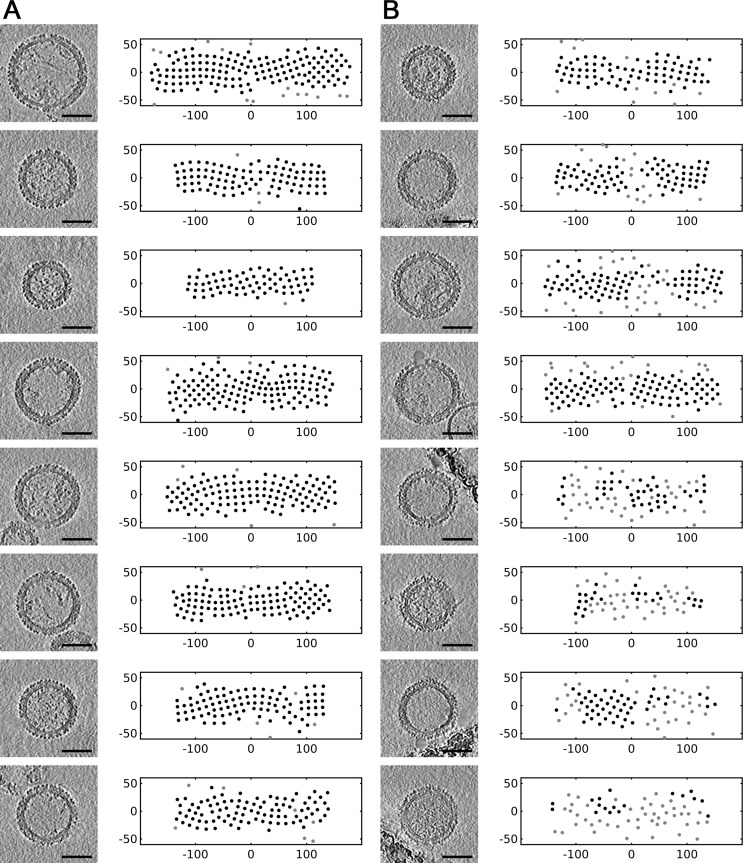
Treatment with Fab P-4G2 alters the presentation of the hantaviral glycoprotein lattice at the surface of Puumala virus (PUUV) virus-like particles (VLPs).Tomographic slices of the selected PUUV VLPs (left) and corresponding Mercator projections (right) describing the positions of (Gn−Gc)4 spikes on VLP surfaces are shown (A) in the absence and (B) presence of Fab P-4G2. The subset of spike positions that belong to regular patches (determined using the PatchFinder script; please see main Methods) are displayed in black and the remainder in gray. Units shown are in nanometers and scale bars are 50 nm.